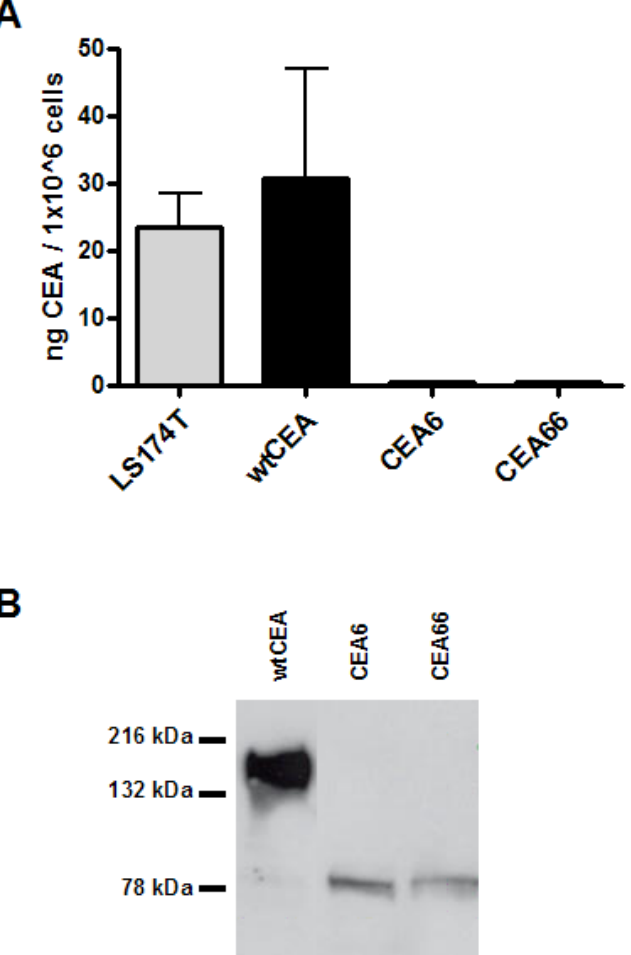
FIGURE 4. Truncated CEA proteins are retained within the producing cell. (A) Concentrated culture supernatants from CEA-transfected HeLa cells were subjected to an CEA inhibition ELISA. The amount of soluble CEA in the culture medium was expressed as ng CEA per 1 million cells. The mean ± SEM of three experiments is shown in the figure. (B) A representative western blot showing CEA expression by transfected HeLa cells used in panel